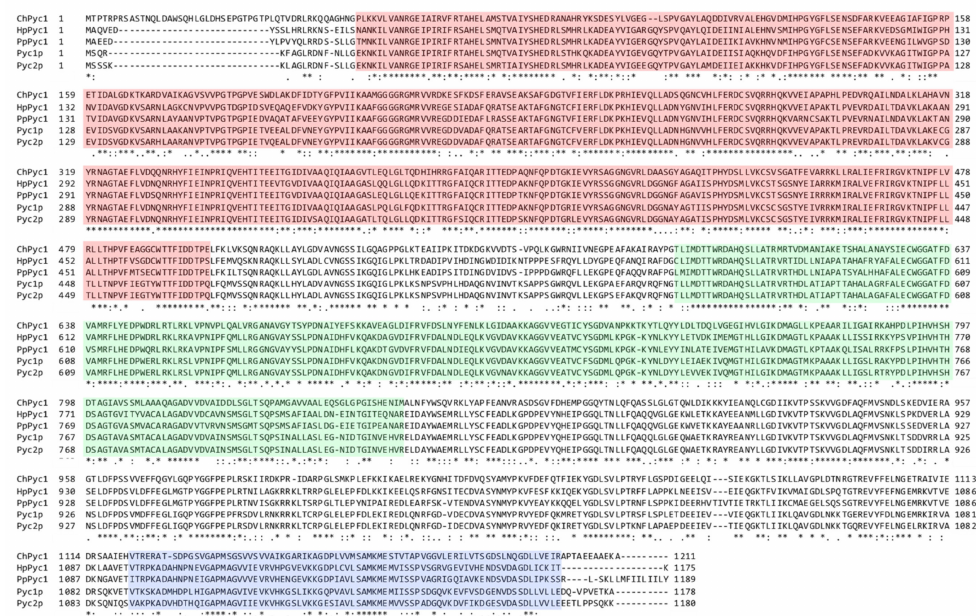
Figure 1. Comparison of amino acid sequences of ChPyc1 with HpPyc1 ( H. polymorpha , Uniprot: A0A1B7SK73), PpPyc1 ( P. pastoris , P78992), Pyc1p, and Pyc2p ( S. cerevisiae , P11154 and P32327, respectively). Identical residues and amino acid substitutions with low and high similarity are indicated by asterisks, dots, and double dots, respectively. The regions boxed in red, blue, and green correspond to BC, TC, and BCC domains, respectively, of Pyc functional domains [38].